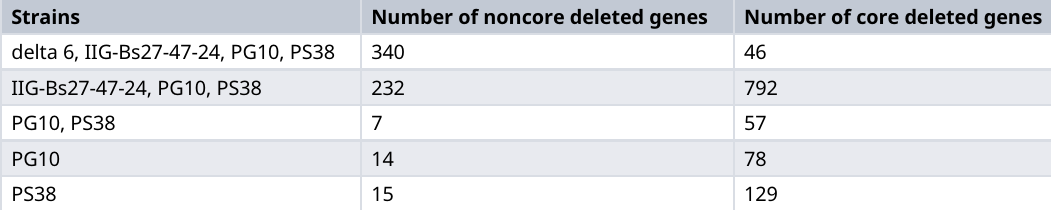
Table 3. The number of deleted genes from B. subtilis reduced strains which are noncore versus core.